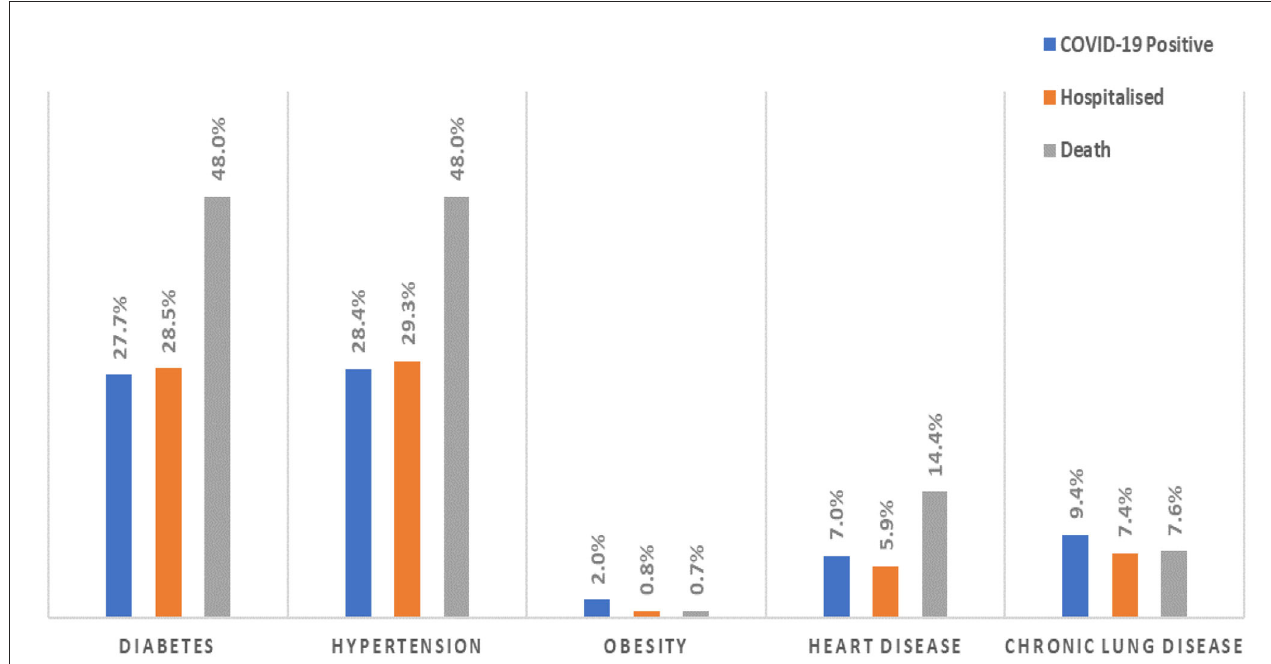
FIGURE3 The proportion of patients with comorbidities among patients positive for COVID-19 and their severe outcomes (hospitalized and death).